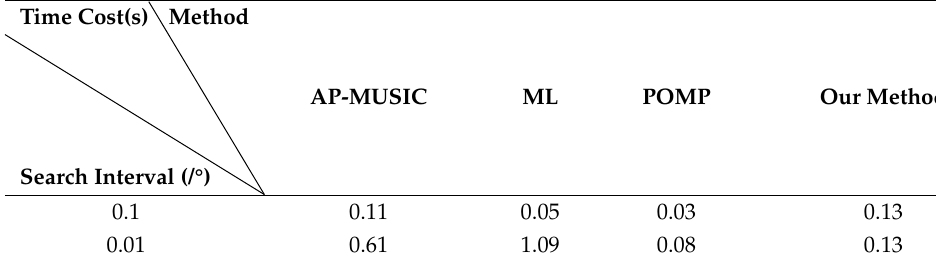
Table 1. Comparison results of the running time costs of the different methods.